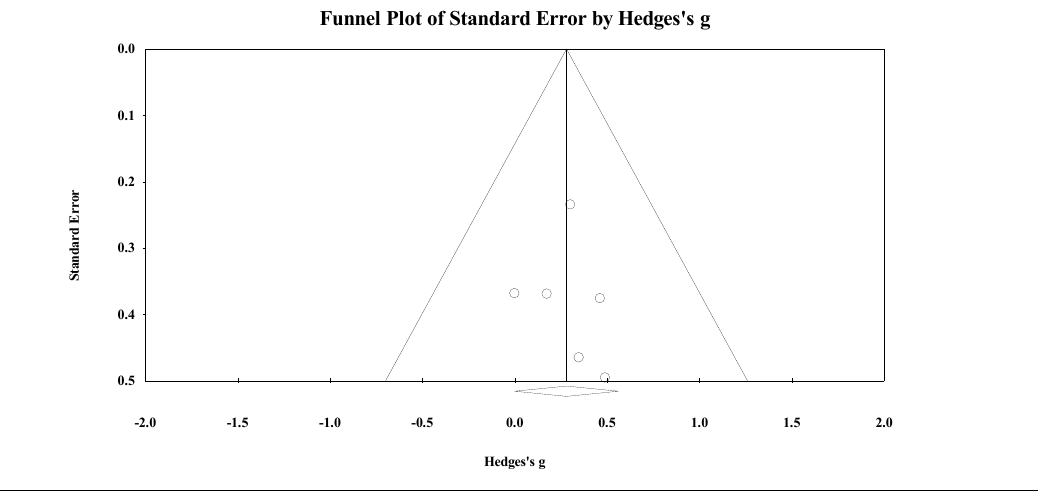
Figure 10. Forest plot of changes in lower-body bone mineral density in untrained adults after a training program based on soccer small-sided games (SSG) compared to active controls. Values shown are effect sizes (Hedges’s g) with 95% confidence intervals (CI). The size of the plotted squares reflects the statistical weight of each study. The black diamond reflects the overall result.